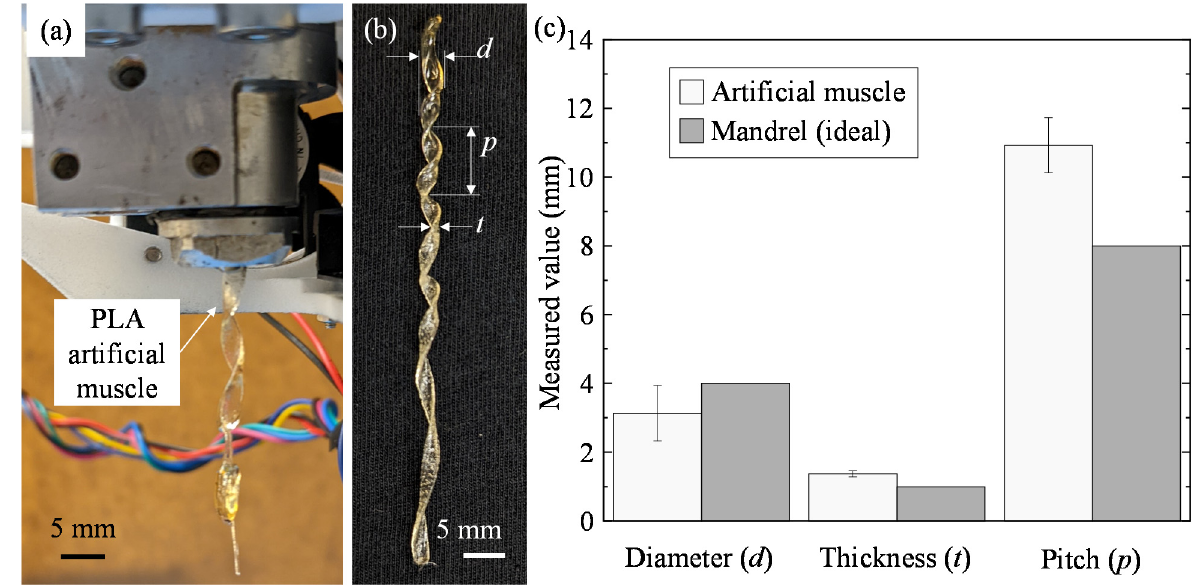
Figure 7. ( a ) Helical artificial muscle extrusion. ( b ) Extruded artificial muscle with key dimensions: muscle diameter ( d ), thickness ( t ), and pitch ( p ). ( c ) Comparison between the measured dimensions and the key dimensions of the fluted mandrel.